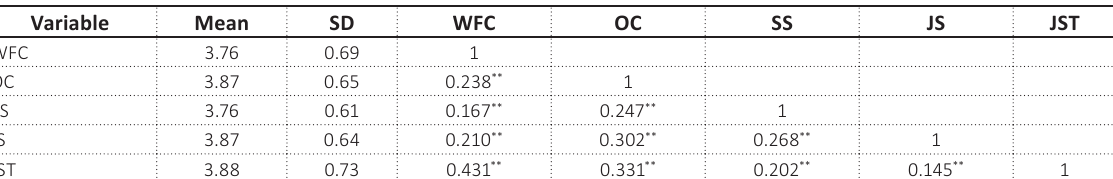
Table 1. Correlation among construct